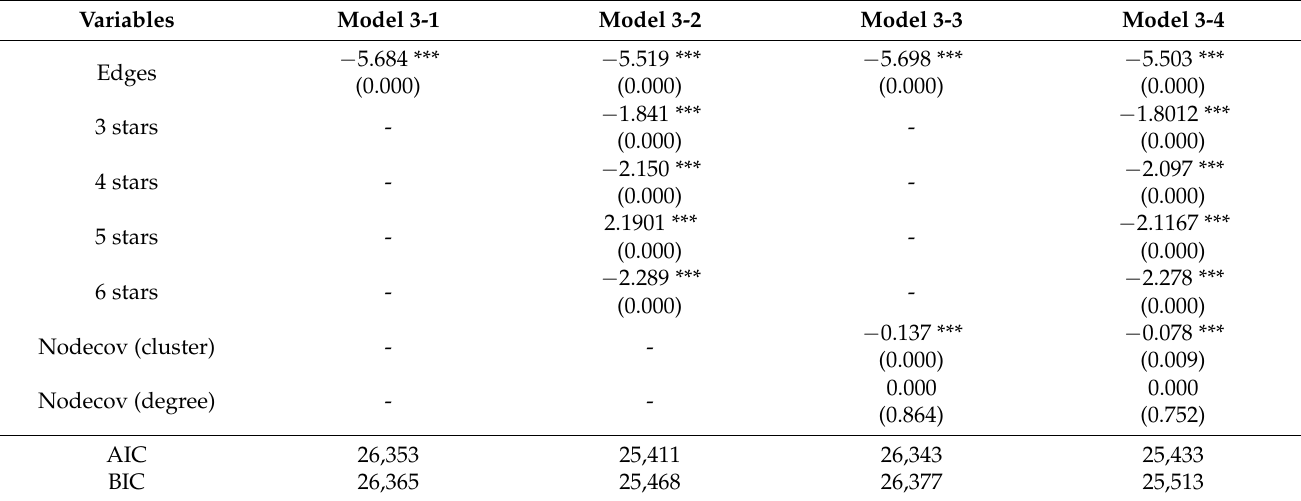
Table 8. Results of the social network